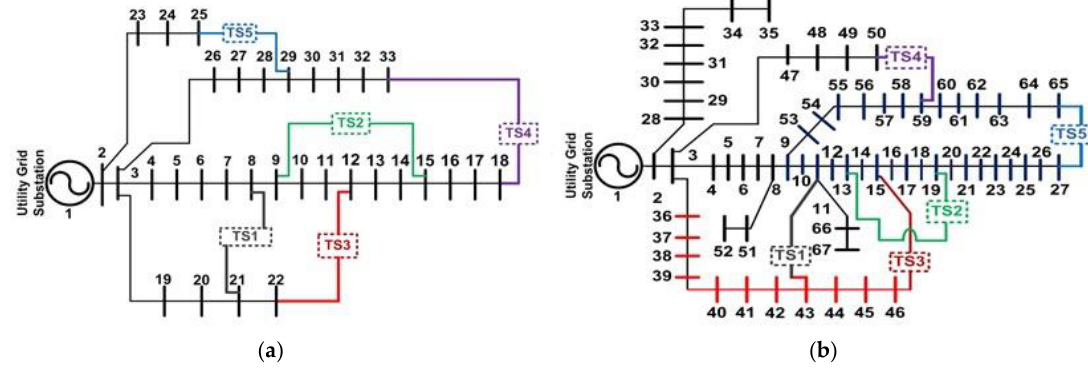
Figure 5. ( a ) 33-Bus Test Distribution System; ( b ) 69-Bus Test Distribution System.